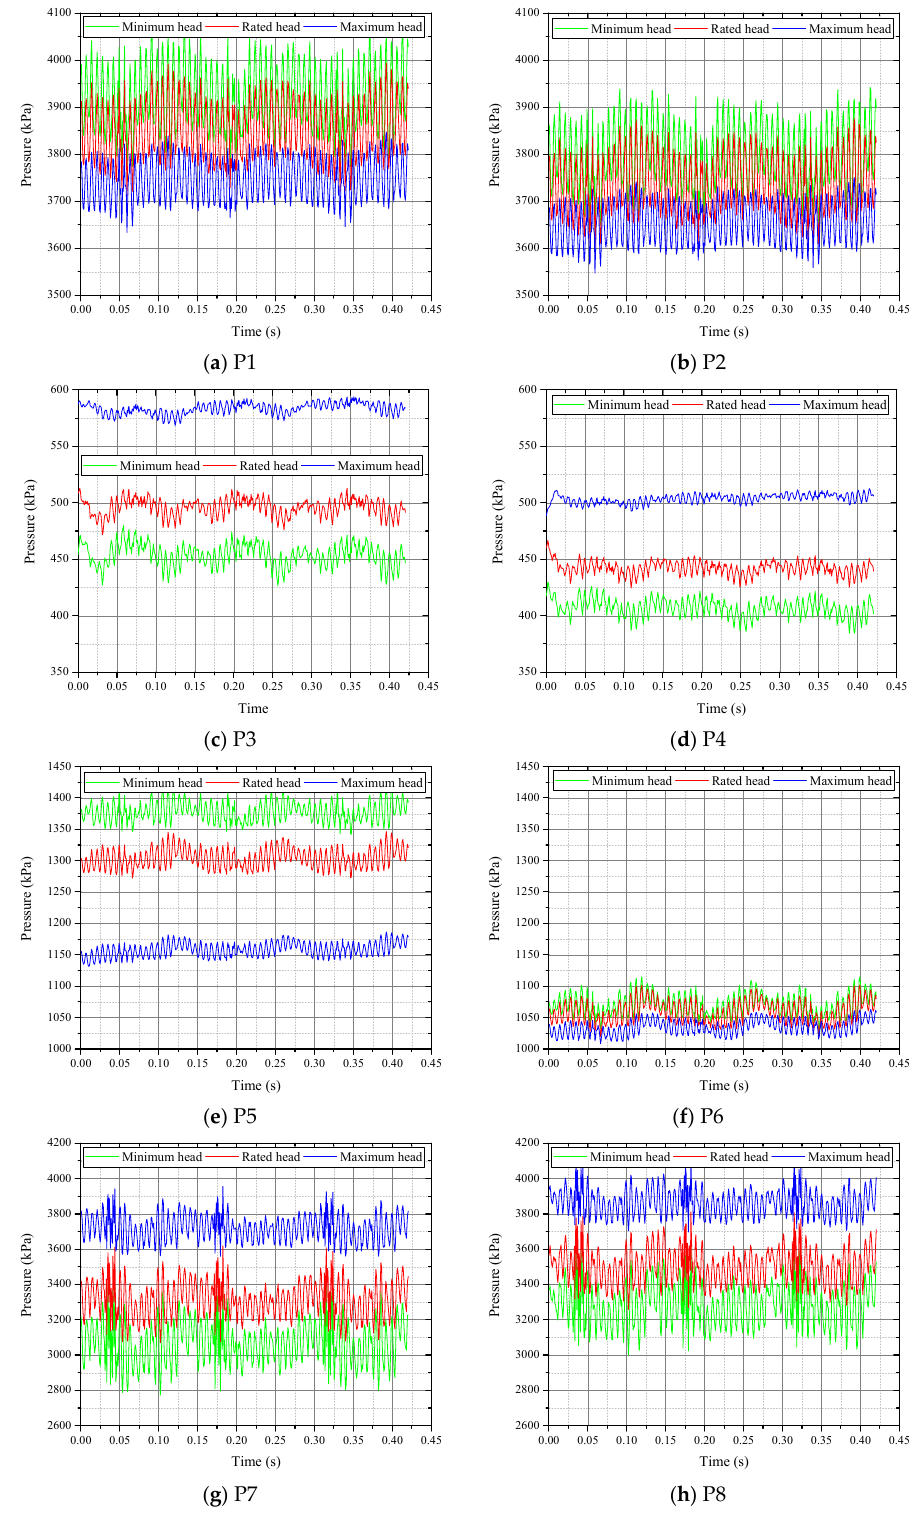
Figure 7. Pressure pulsation at monitoring points at three analyzed operating heads.